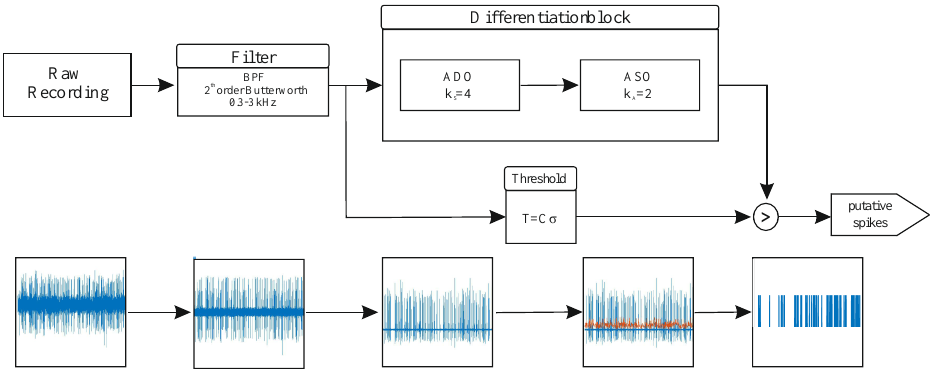
Figure 2. Workflow and dataflow of proposed spike detector.